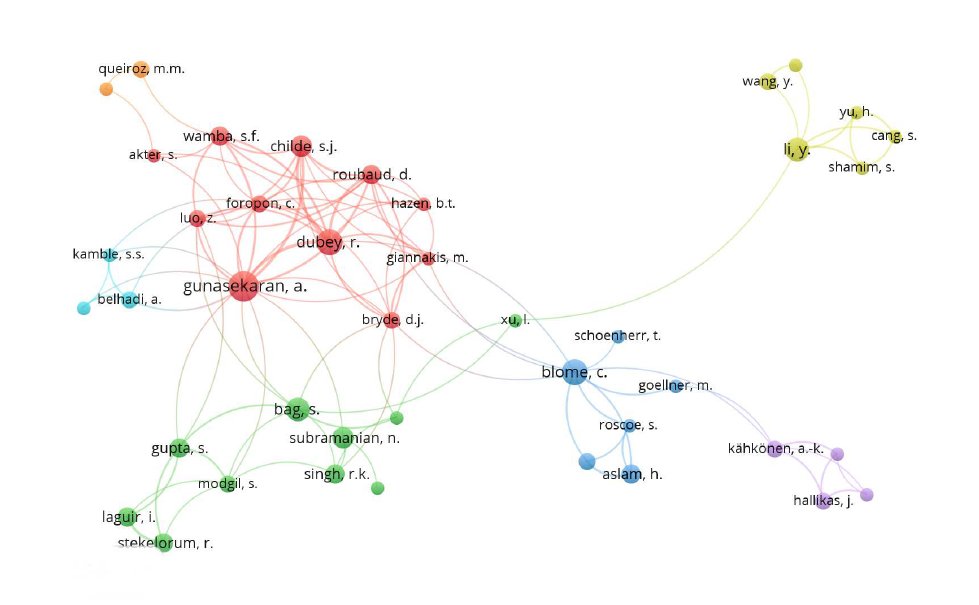
Figure 6. Concepts related to supply chain and DC in Web of